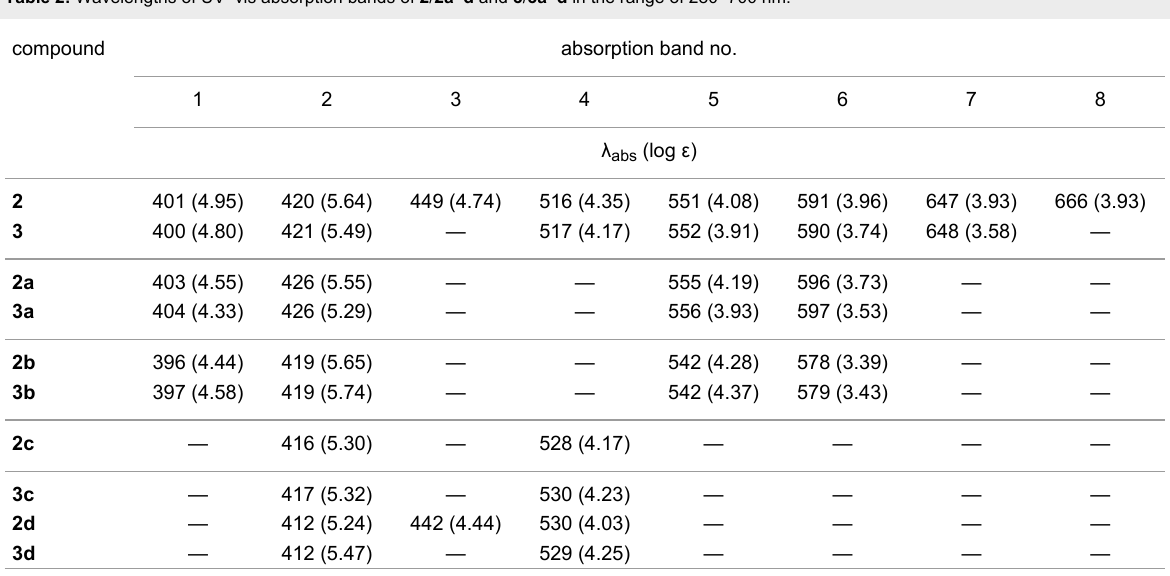
Table 2: Wavelengths of UV–vis absorption bands of 2 / 2a – d and 3 / 3a – d in the range of 280–700 nm. a compound absorption band no.